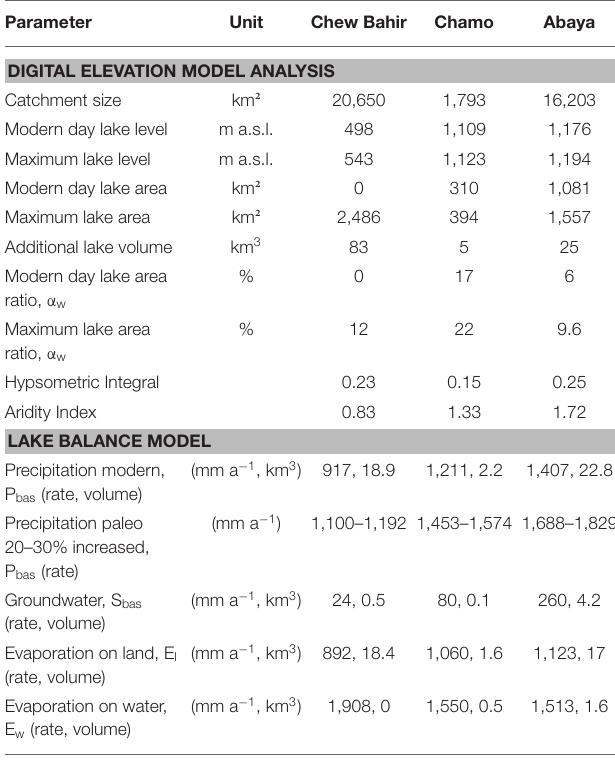
TABLE 3 | Summary of major output